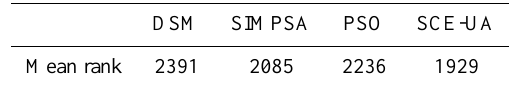
Table 5. p -values for pairwise Wilcoxon rank sum tests between different optimization